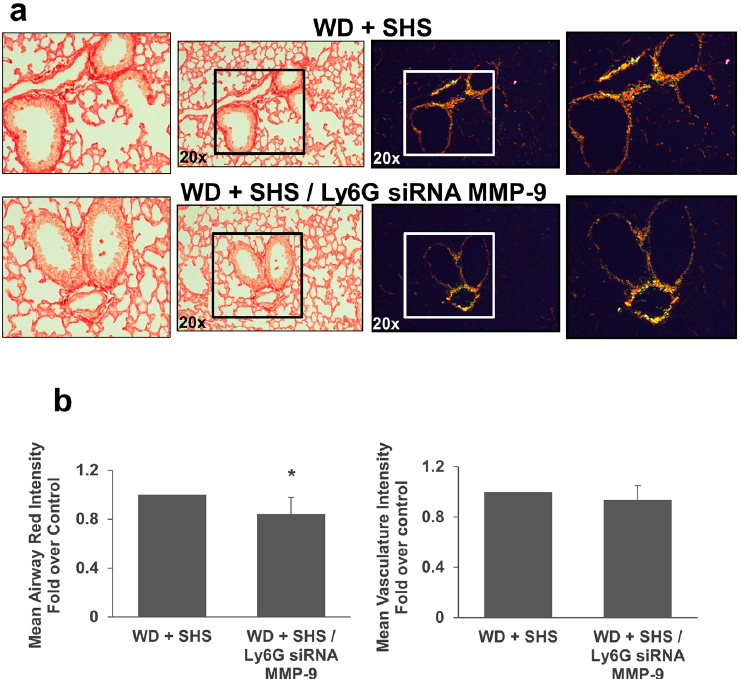
Figure 8. Collagen deposition in lungs of ApoE − / − mice fed WD and exposed to SHS only (WD + SHS), or treated with PMN targeted siRNA for MMP-9 (WD + SHS/Ly6G siRNA MMP-9). Picro-sirius red stained sections from ApoE − / − mice were viewed under regular light (left panels) or polarized light (right panels). Representative images are shown ( a ). Differences in hue of Picro-sirius red stained airways were evaluated using ImageJ software. Results are expressed as mean red component intensities (airway) or mean total intensity (vasculature) ( b ). PMN targeted MMP-9 specific siRNA impacted collagen deposition. The non-parametric Mann-Whitney test (airway, p > 0.001) or Student’s t -test (vasculature, p = 0.098) were used to assess statistical significance between groups as indicated by group normality, five mice per group were evaluated. * Significant difference detected.